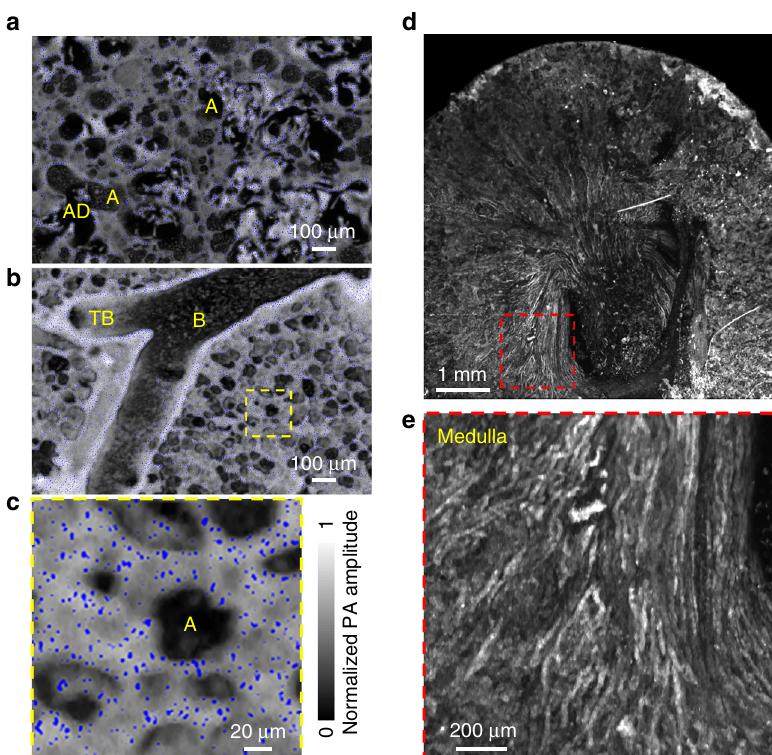
Fig. 5 Label-free mPAM images of an unstained formalin- fi xed mouse lung embedded in a paraf fi n block and an unstained fresh mouse kidney embedded in an agarose block. a , b Two x – y sections of the mouse lung. c Close-up image of the yellow dashed region in b . A, alveoli; AD, alveolar duct; B, bronchiole; TB, terminal bronchiole. d A x – y section of the mouse kidney. e Close-up image of the red dashed region in